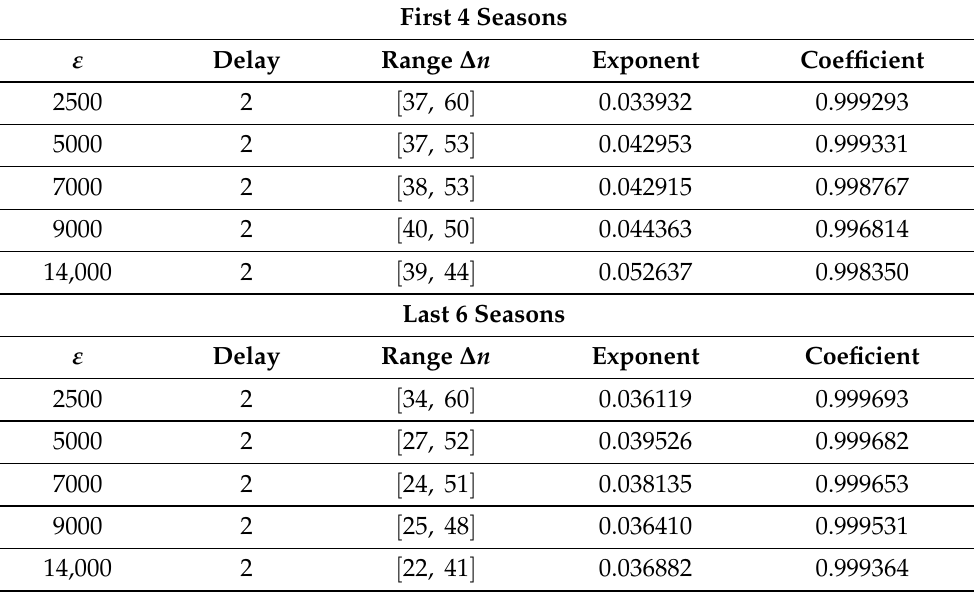
Table 5. Maximal Lyapunov exponents for coop1 subseries.